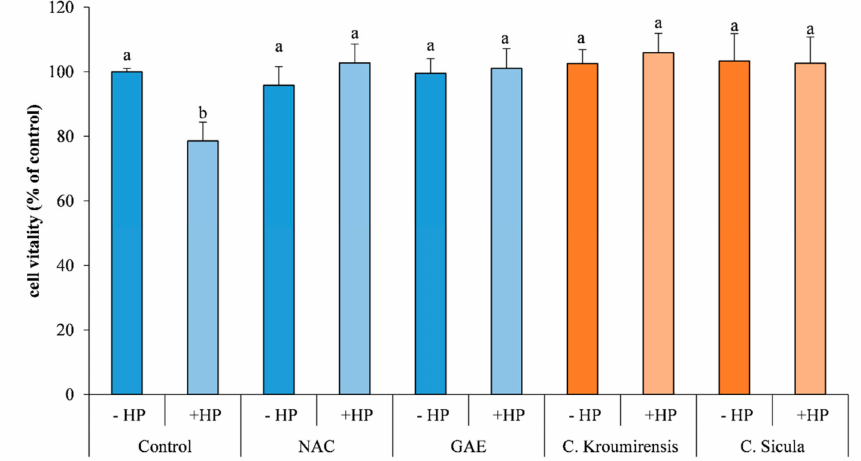
Figure 5. E ff ect of UE Centaurea extracts on HS-68 fibroblast cells exposed to oxidative stress, induced by H 2 O 2 . HP = hydrogen peroxide, Control cells, NAC = cells pretreated with the synthetic antioxidant NAC, GAE = cells pretreated with gallic acid, cells pretreated with UE extract of C. kroumerienis , cells pretreated with UE extract of C. sicula. (Di ff erent letters indicate significant di ff erence ( p <